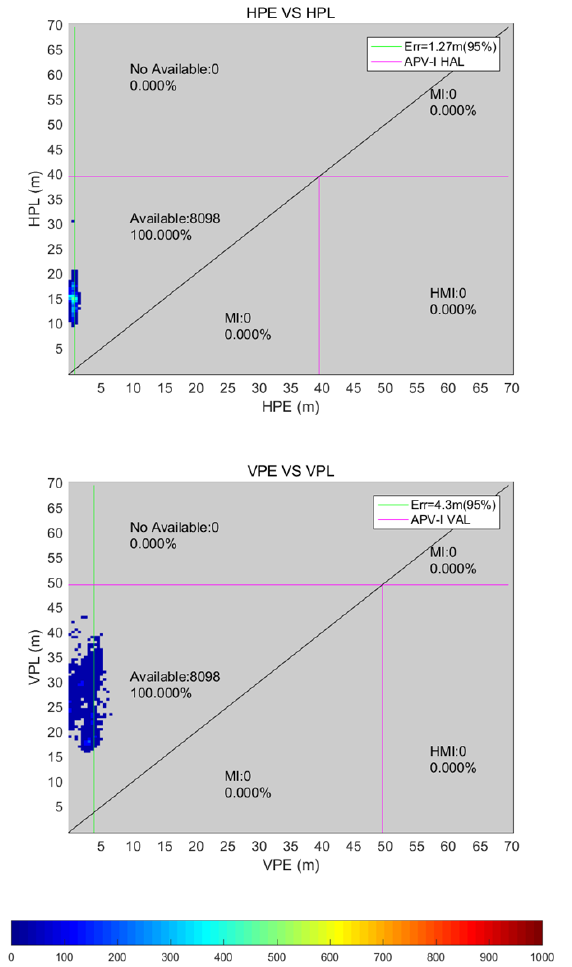
. Figure 18. Stanford triangle charts for flight test-II. The top panel and the bottom panel are the horizontal Stanford chart and the vertical Stanford chart, respectively. Table 3. BDSBAS SF performance statistics of flight